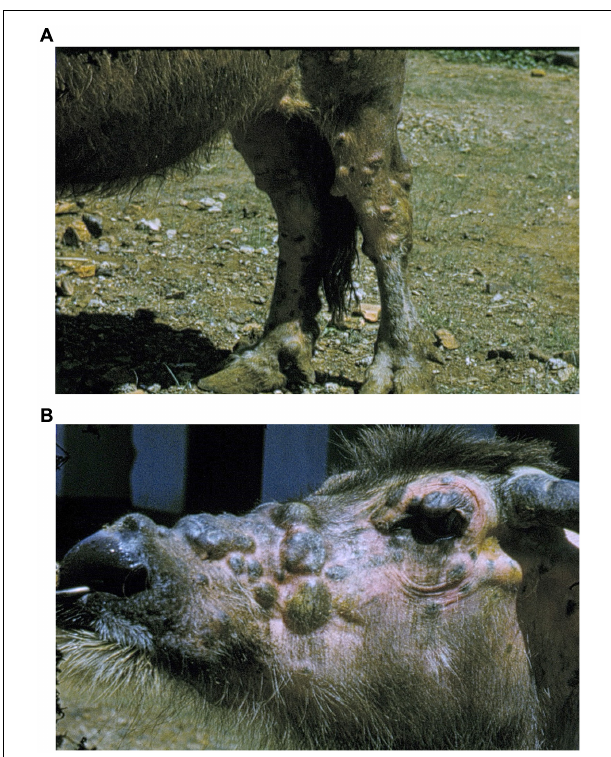
FIGURE 4 | (A) Water buffalo with extensive skin lesions. (B) Image from colour film by Ressang (1961).